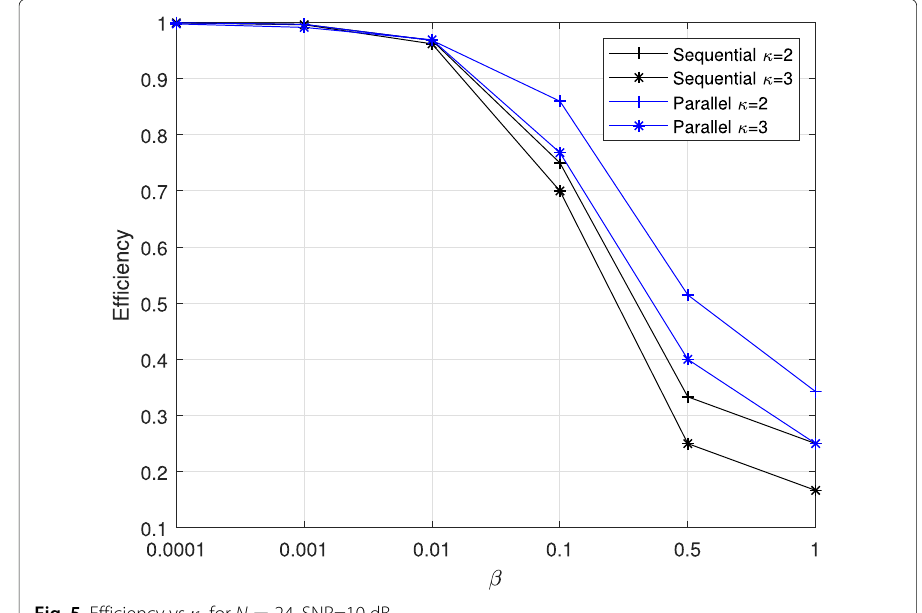
Fig. 5 Efficiency vs κ , for N = 24, SNR=10